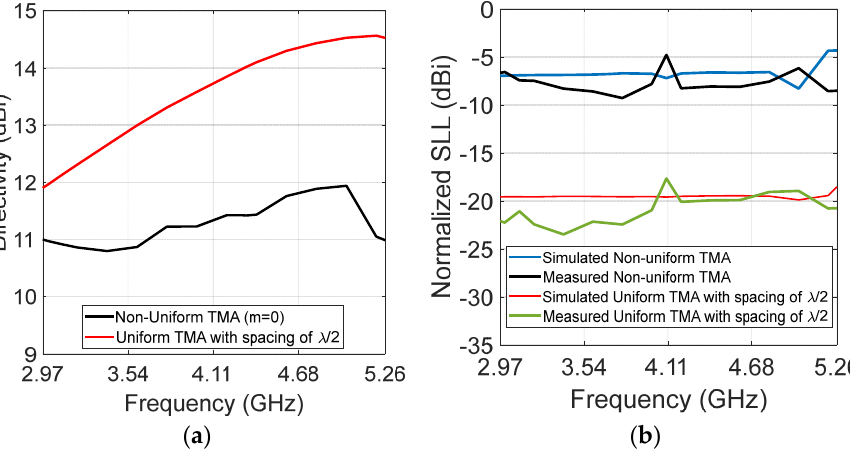
Figure 7. Array performance: ( a ) directivity; ( b ) normalized SLL.